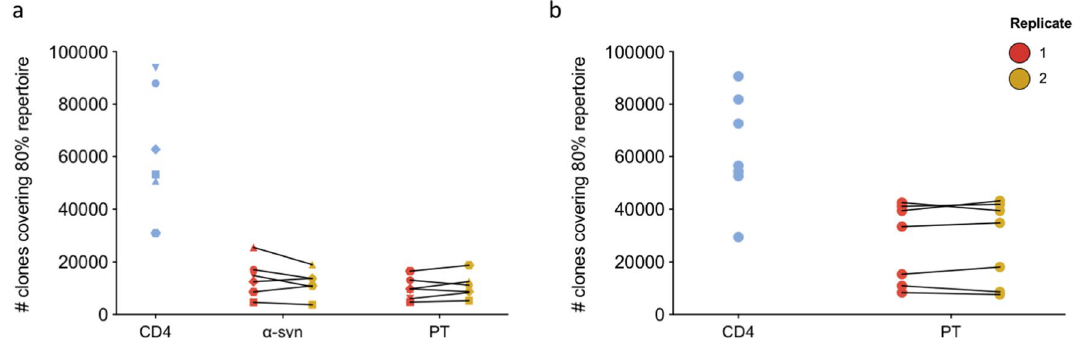
Figure 2. Similar number of clonotypes expand in response to α-syn and PT peptide pools. Number of TCR clonotypes covering 80% of the productive repertoire. Ex vivo CD4 repertoire (blue) captured immediately following thaw. Two replicates (red and yellow) were sequenced for each peptide pool stimulation (14-day in vitro expansion). Each point and symbol represents one participant. a PD n = 6, b HC n =